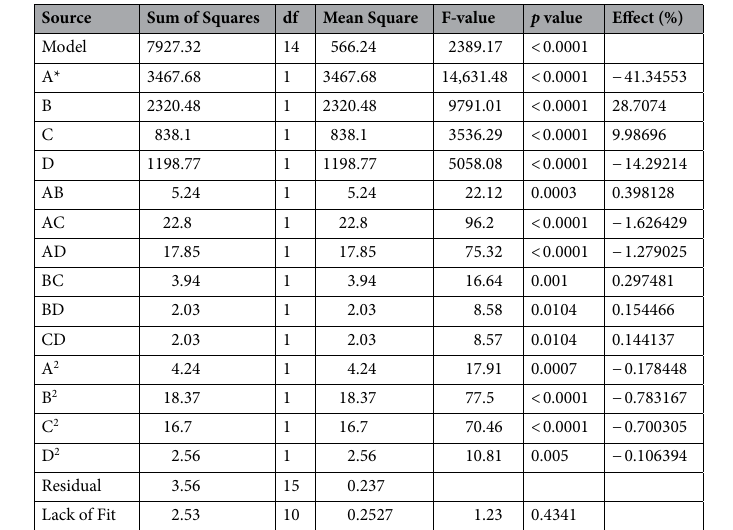
Table 3. ANOVA results for As(V) adsorption on amino-MIL-68(Al). *A, B, C and D represent the independent variables defined in Table 1.